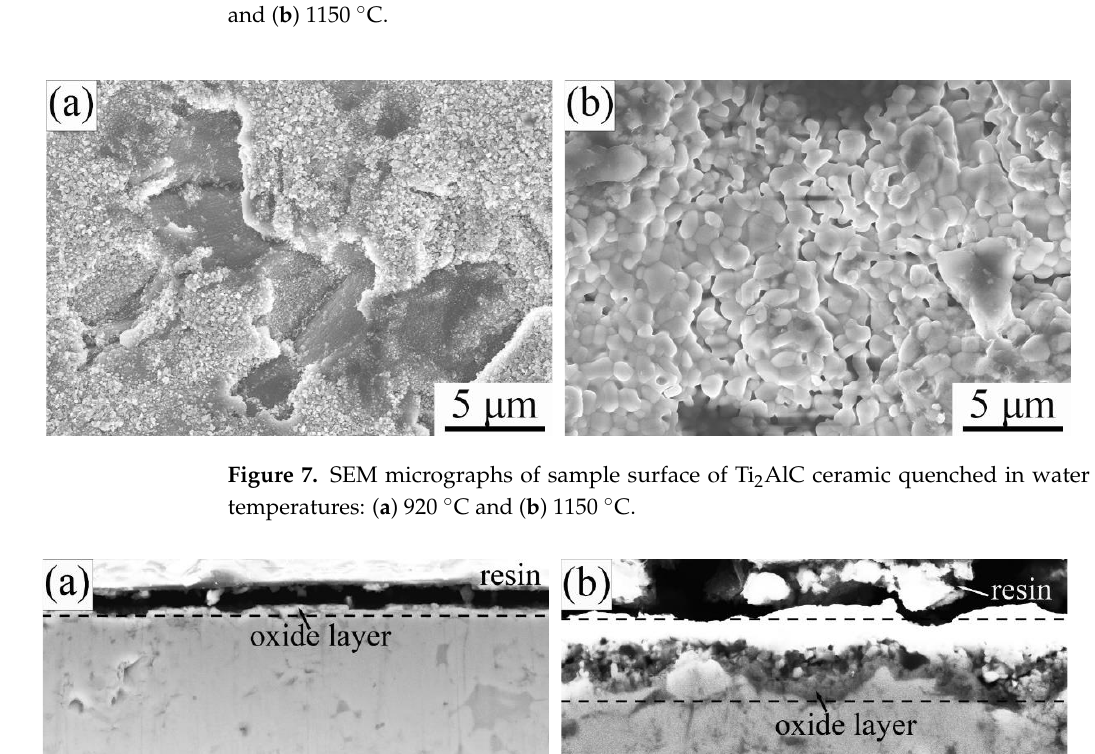
Figure 6. EDS patterns of Ti 2 AlC samples quenched in water at different temperatures: ( a ) 920 °C and ( b ) 1150 °C. Table 3. Phase compositions of the sample ’s surface of water-quenched Ti 2 AlC ceramic heated in air at different temperatures.